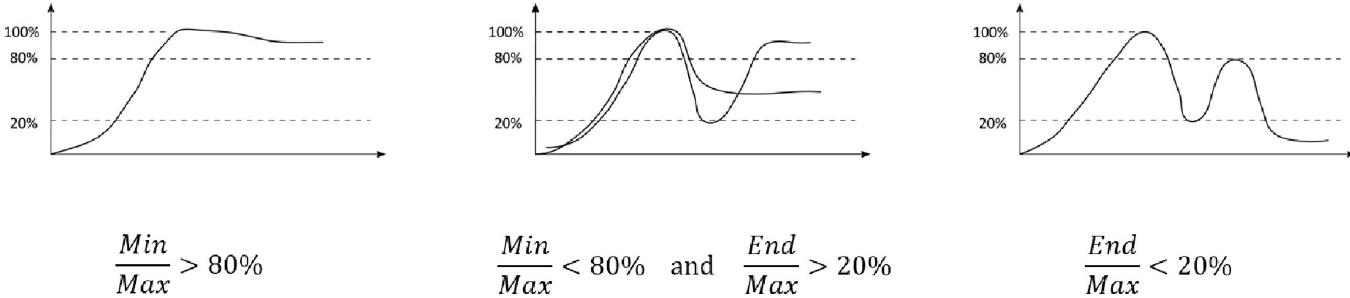
Fig 5. Cochlea microphonic waveform examples for each of the Growth (n = 11), Fluctuating (n = 25) and Total loss (n = 4) groups and the threshold calculations used to define them.